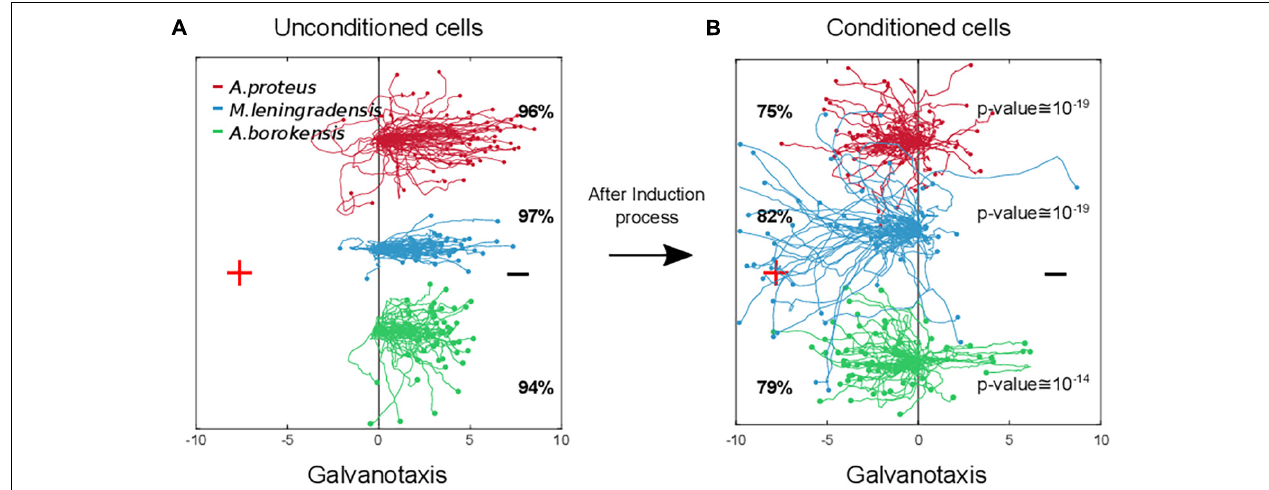
FIGURE 3 | Comparison of amoebae migrations under two galvanotaxis conditions, before and after being conditioned. In red Amoebae proteus , in blue Metamoeba leningradensis , and in green Amoebae borokensis . (A) When galvanotactic stimulus was applied, practically all the cells of the three species migrated toward the cathode. (B) After induction process (simultaneous galvanotactic and chemotactic stimuli for 30 min, see Figure 2 ) a new locomotion pattern had appeared in the cells, and the majority of amoebae moved toward the anode in the absence of peptide (75, 82, and 79% of the A. proteus, M. leningradensis and A. borokensis , respectively). The p -Values obtained when the displacement cosines of galvanotaxis and conditioning tests for each species were depicted, these values indicated that this newly acquired cellular behavior is extremely unlikely to be obtained by chance. The three species responded similarly, suggesting the presence of associative conditions in most of them (78% on average). “+” indicates anode, while “ − ” cathode. The x -axis shows the distance in